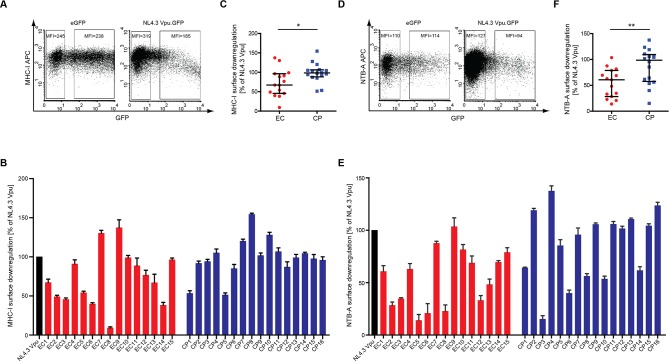
MHC-I and NTB-A downregulation by patient-derived Vpus.Surface MHC-I and NTB-A levels were analyzed by flow cytometry on A3.01 cells 48 h post transfection with the indicated Vpu.GFP expression constructs. A) Representative flow cytometry dot plots of gated living cells for MHC-I-APC (y-axis) vs. GFP (x-axis). The MFI (Y Geo Mean) of untransfected (left gate) and medium to high GFP-expressing (right gate) cells is indicated. MHC-I cell surface levels of transfected cells were normalized to untransfected cells in the same sample by calculating the ratio of the MFIs of right and left gates and expressed relative to that of NL4.3 Vpu that was arbitrarily set to 100%. B) MHC-I cell surface levels of A3.01 cells expressing patient derived Vpu proteins relative to NL4.3 Vpu. Shown are mean values of triplicate transfections with the indicated standard deviation. The result is representative of three independent experiments. C) Comparison of MHC-I cell surface levels in A3.01 cells expressing EC or CP Vpu alleles. Statistical significance was assessed using two-tailed Mann-Whitney U-Test (p = 0.02), bars represent median and interquartile ranges. D) Representative flow cytometry dot plots of gated living cells for NTB-A-APC (y-axis) vs. GFP (x-axis). The MFI (Y Geo Mean) of untransfected (left gate) and medium to high GFP-expressing (right gate) cells is indicated. NTB-A cell surface levels of transfected cells were normalized to untransfected cells in the same sample by calculating the ratio of the MFIs of right and left gates and expressed relative to that of NL4.3 Vpu that was arbitrarily set to 100%. E) NTB-A cell surface levels of A3.01 cells expressing patient derived Vpu proteins relative to NL4.3 Vpu. Shown are mean values of triplicate transfections with the indicated standard deviation. The result is representative of three independent experiments. F) Comparison of NTB-A cell surface levels in A301 cells expressing EC or CP Vpu alleles. Statistical significance was assessed using two-tailed Mann-Whitney U-Test (p = 0.01), bars represent median and interquartile ranges.